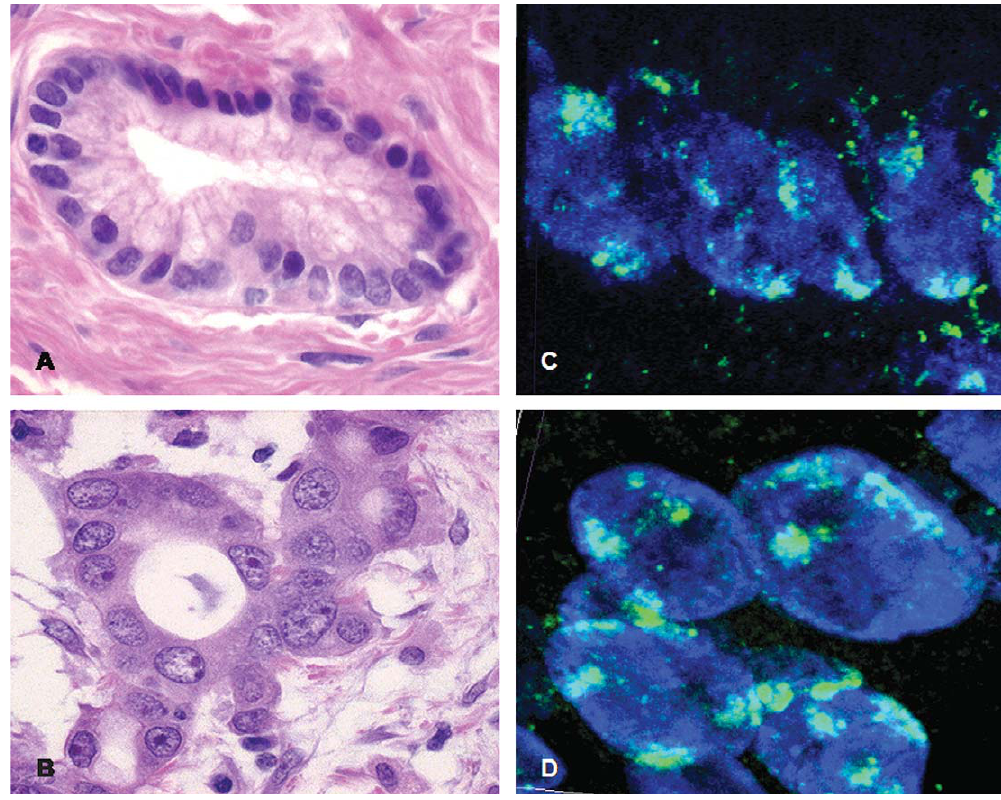
Fig. 1. A: Non-neoplastic (normal) pancreatic ductal epithelium: H&E staining, 600 × ; B: Neoplastic epithelium (pancreatic ductal adeno- carcinoma): H&E staining, 600 × ; C: Non-neoplastic (normal) pancreatic ductal epithelium: WCP8 FISH, 1000 × ; D: Neoplastic epithelium (pancreatic ductal adenocarcinoma): WCP8 FISH, 1000 ×